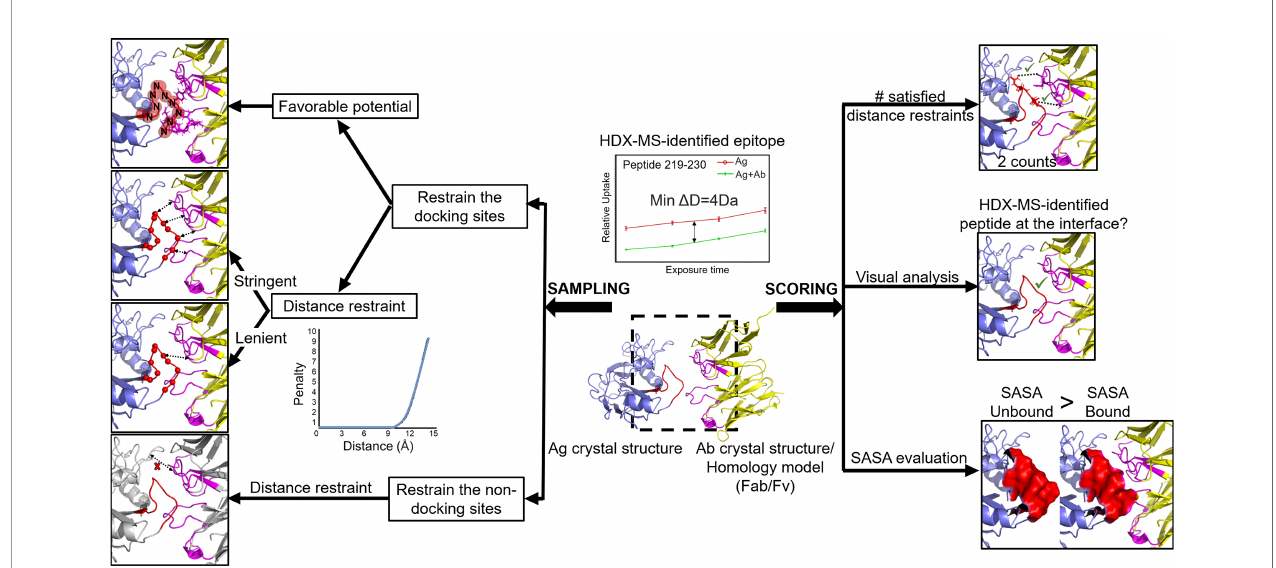
FIGURE 6 | Different practices have been used to incorporate HDX-MS data into Ab-Ag docking. HDX-MS data are provided in form of identi fi ed epitope peptides (e.g., peptide 219-230 with a decrease in deuterium level of at least 4Da across 4 timepoints). Docking components: Ag crystal structure (blue; HDX-identi fi ed peptide: red) and Ab (Fab or Fv) crystal structure or homology model - (yellow; CDRs: pink). Sampling stage: (A) Restrain the docking sites. Favorable potential (red sphere) - spheres surrounding the backbone N atoms in the epitope are fi lled with favorable values. Each atom of the Ab lying within this sphere would contribute a favorable potential to the energy function. Distance restraint (left right arrows) - a minimum number of residues from each epitope peptide must be within a speci fi ed threshold distance to the Ab. Lenient approach: one residue from the epitope peptide to be at the interface. Stringent approach: the minimum number of contact residues correlates with the decrease in deuterium level (i.e., 4 residues in this case). (B) Restrain the non-docking sites: non-epitope peptides and non-CDR regions (grey) are blocked from docking using distance restraint. Scoring stage: HDX-MS data is applied as fi lters in form of: the number of satis fi ed distance restraints is - the higher the count (favorable contact) is, the more optimal a docked pose is considered to be; visual analysis - manually inspection of the docked poses on whether the epitope is at the interface; SASA evaluation - SASA calculation of the epitope peptide in the unbound form must be larger than the bound